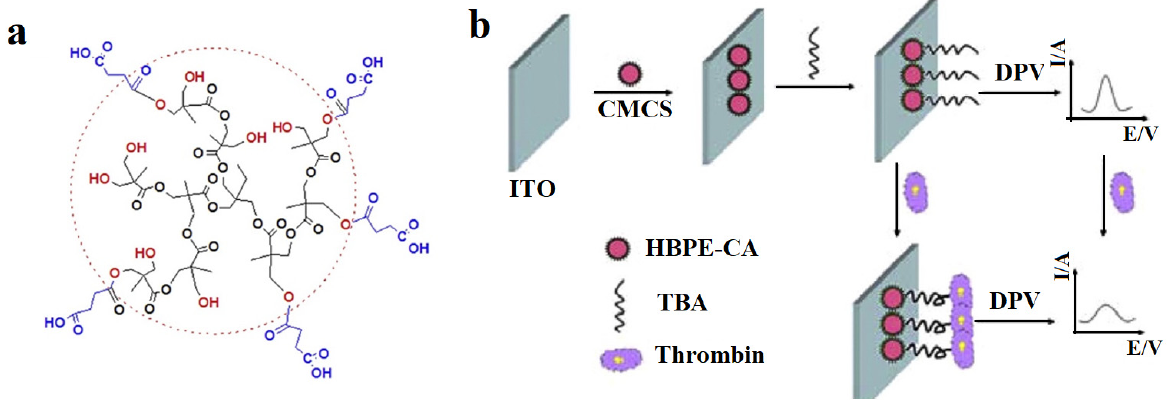
Figure 10. Aptasensor designed for thrombin detection in whole blood samples. ( a ) The chemical structure of HBPE-CA microspheres and ( b ) fabrication and principle of aptasensor. Adapted from [22].